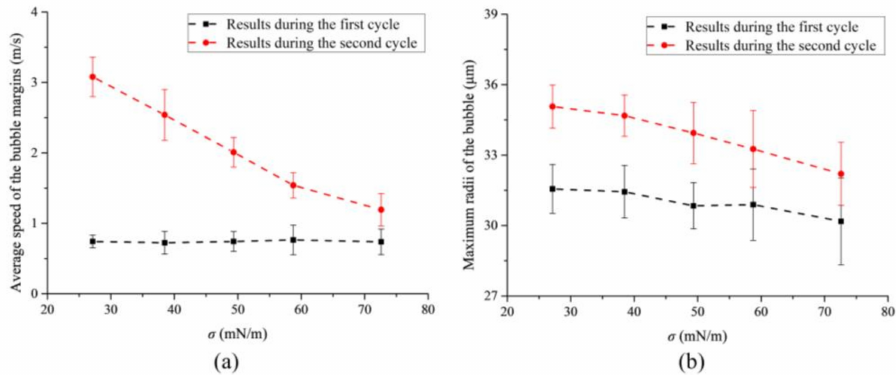
Figure 7. ( a ) The average speed and ( b ) the maximum bubble radius during bubble oscillating as functions of the liquid’s surface tension.